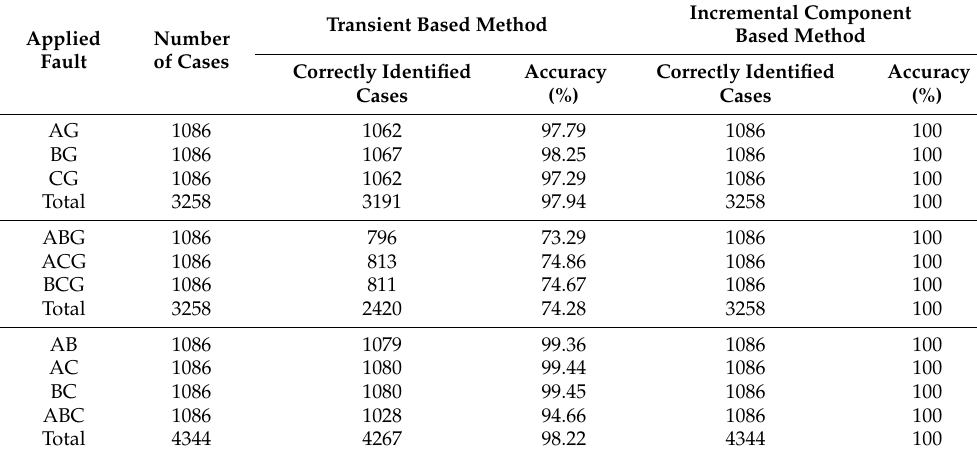
Table 6. Overall performance of transient-based and incremental component-based faulted phase identification